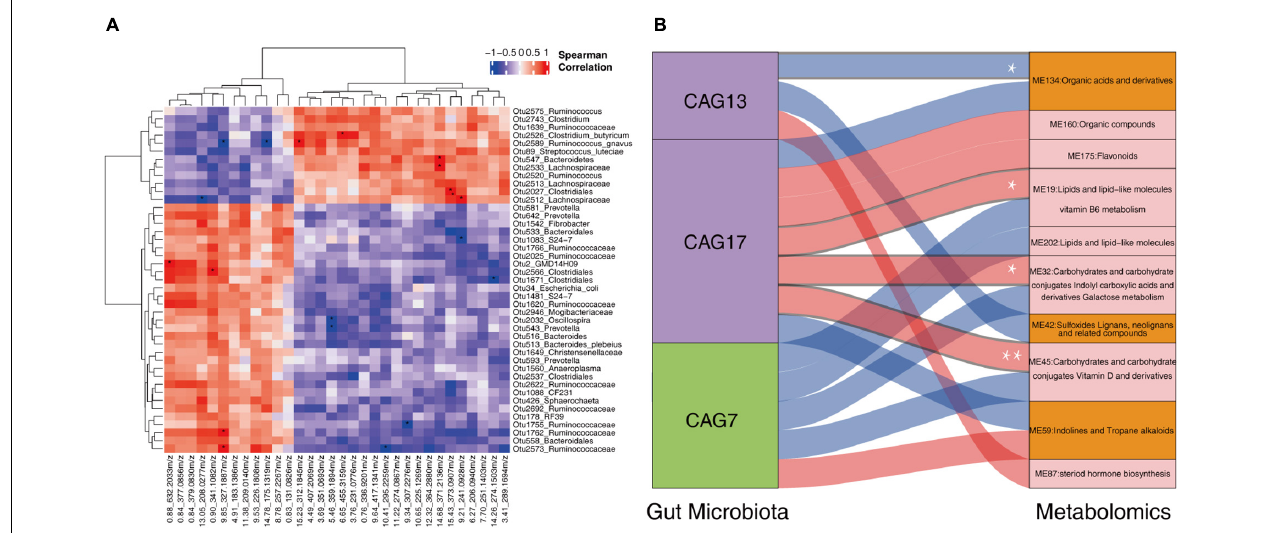
FIGURE 7 | The correlations between fecal microbiota and host serum metabolite profile. (A) The heatmap of the correlations between differential fecal microbiota and serum metabolites. Spearman correlation coefficients were calculated. Red represents positive correlation and blue represents negative correlation. The star in the grid indicates the significant threshold *FDR < 0.05. (B) Spearman correlation analysis between the CAGs and the metabolite modules. The connections with a coefficient greater than 0.4 were plotted. The thickness of the connections between CAGs and metabolic modules represents the weight of the correlation coefficient. Red connections represent positive correlation, and blue connections represent negative correlation. In the column of CAGs, the green box represents the CAGs that were significantly enriched in non-return sows, and the purple boxes represent the CAGs that were significantly enriched in normal return sows. In the metabolome column, the orange boxes represent metabolic modules that were significantly enriched in non-return sows, and the pink boxes represent metabolic modules significantly enriched in normal return sows. *FDR < 0.05, **FDR <